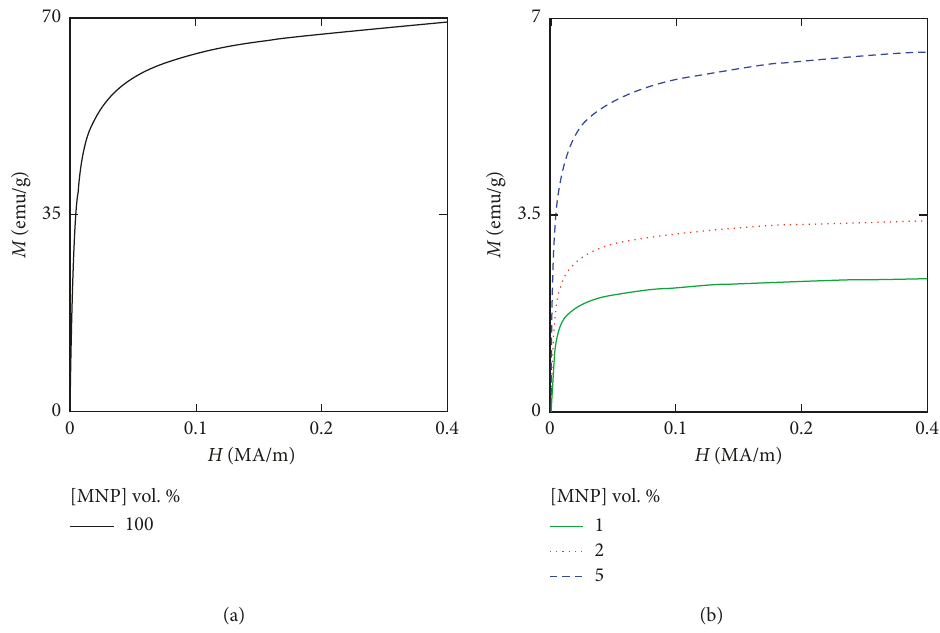
Figure 2: Magnetization curves of (a) maghemite ( c fields of 0.4MA ·